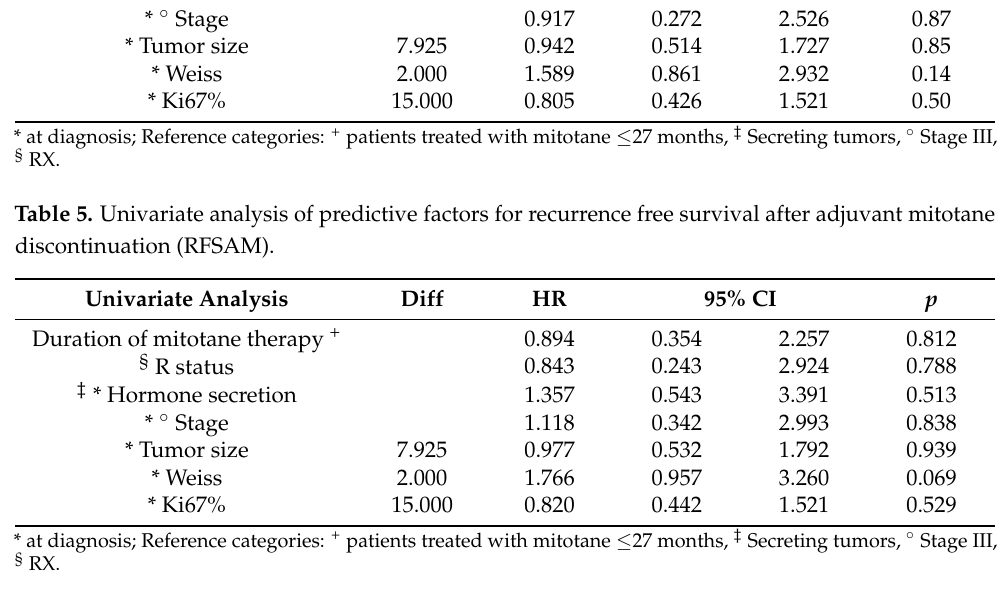
Figure 3. Kaplan–Meier estimates of recurrence free survival after adjuvant mitotane discontinuation (RFSAM) in patients treated <24 months vs. patients treated >24 months. We performed univariate analyses, both for RFS (Table 4) and RFSAM (Table 5), without identifying any significant prognostic factors. Table 4. Univariate analysis of predictive factors for recurrence-free survival (RFS). Univariate Analysis Diff HR 95% CI Duration of mitotane therapy +